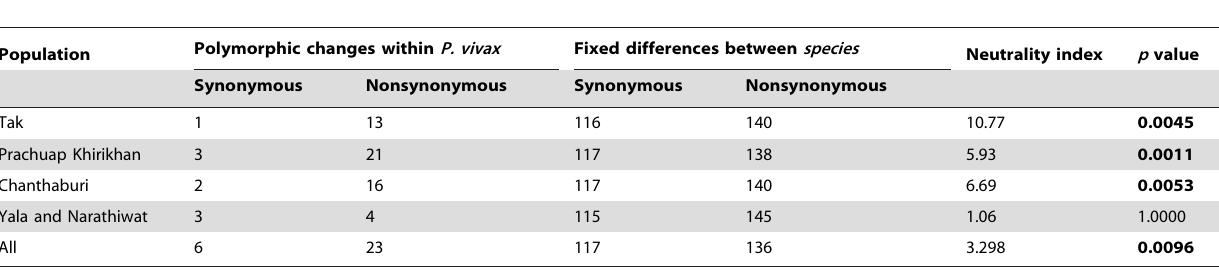
Table 5. McDonald–Kreitman tests on TRAP of Plasmodium vivax from diverse geographic origins with P. cynomolgi orthologue as outgroup